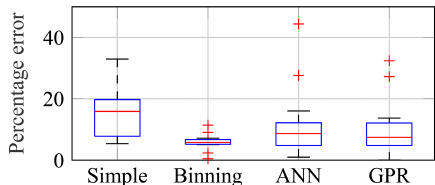
Figure 19. Percentage errors of predicted yearly damage values us- ing all extrapolation methods compared to real yearly damage val- ues. Predictions from a year to a second year for 13 different